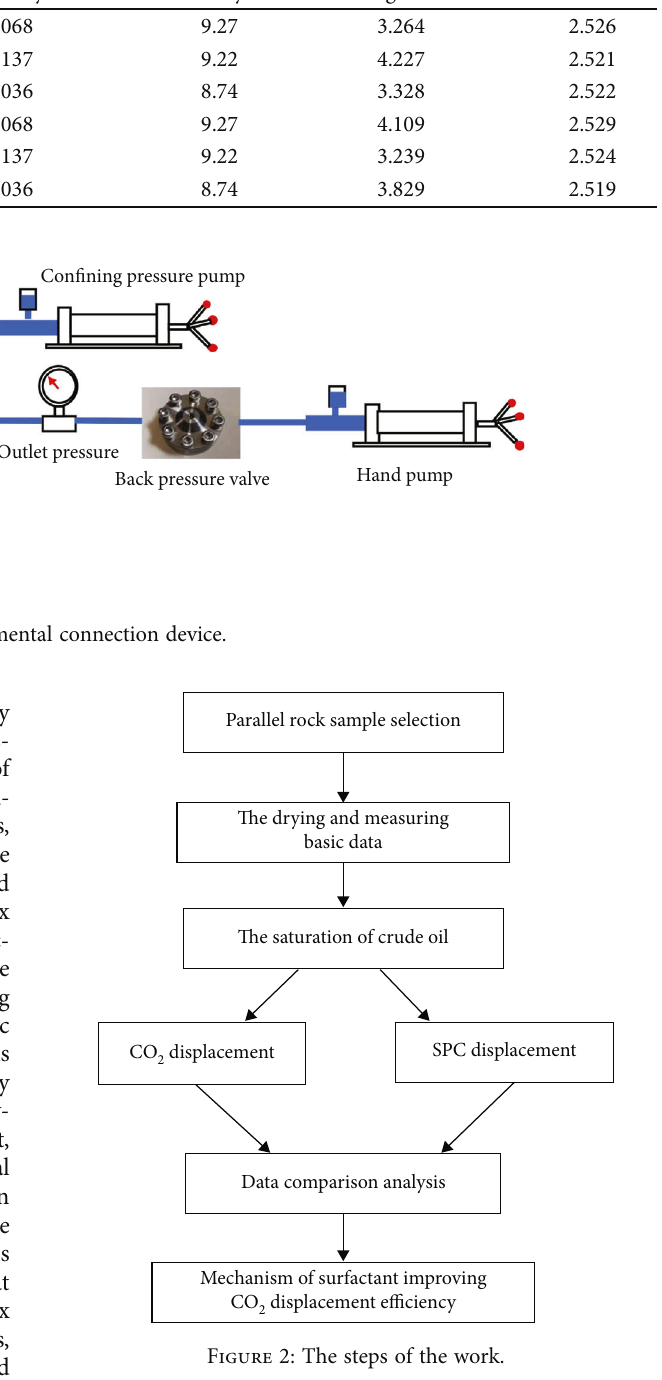
Figure 2: The steps of the